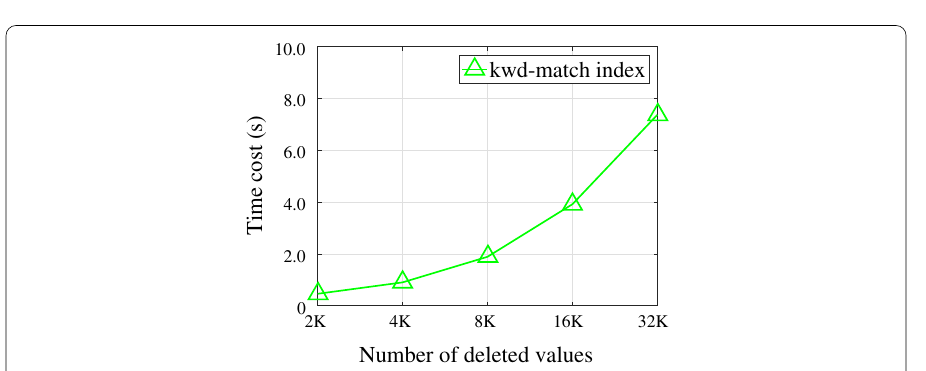
Fig. 7 Secure insertion latency